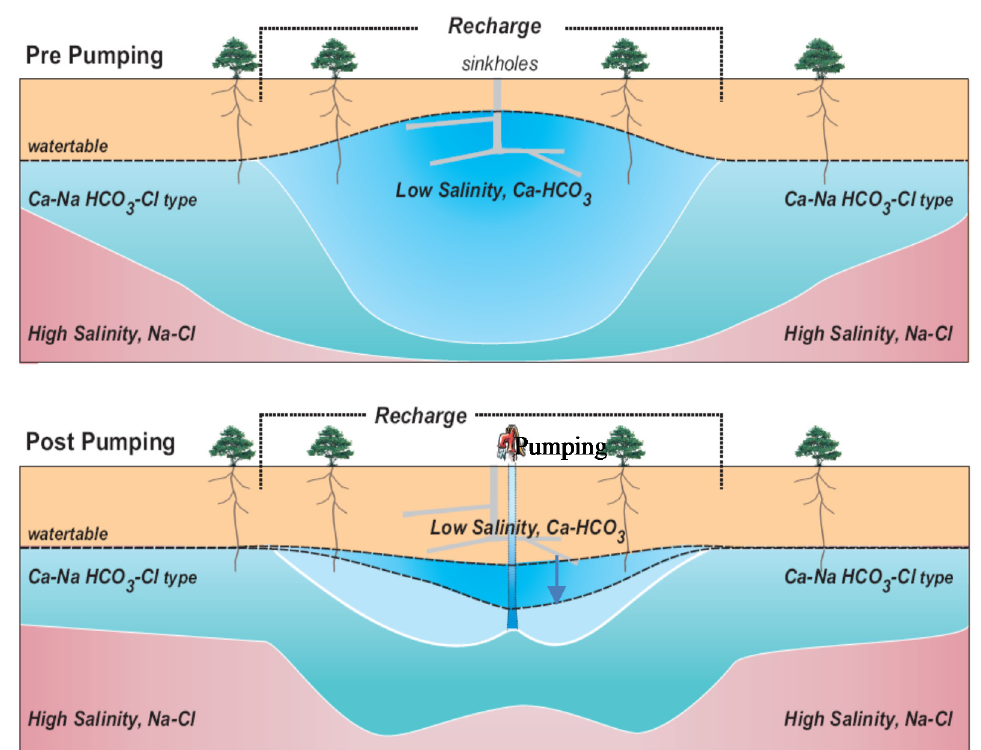
Figure 2. Conceptual diagram of the Robinson